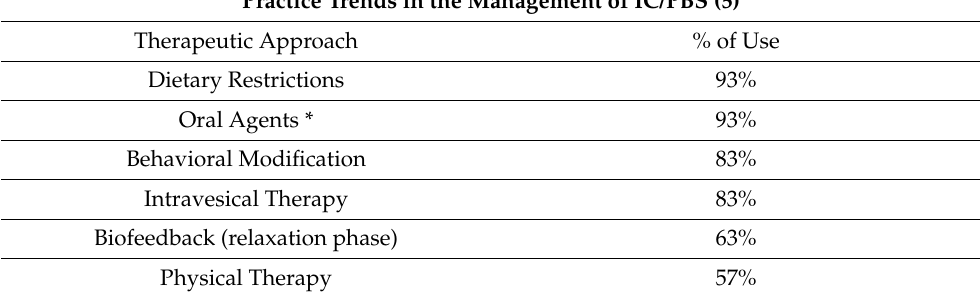
Table 1. Practice trends in the management of IC/PBS. This table illustrates the therapeutic ap- proaches available and the percentage they are utilized, with dietary restrictions and oral agents as the leading